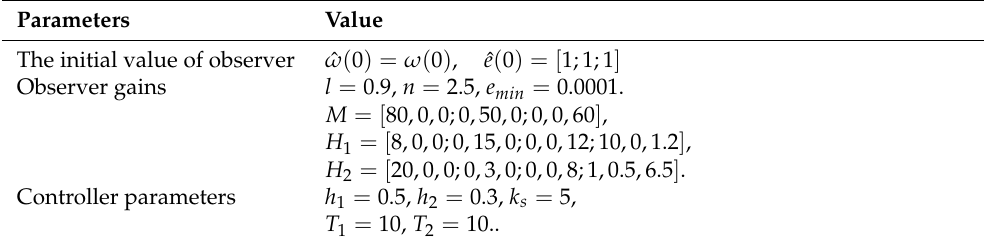
Table 1. Parameters and initial states for